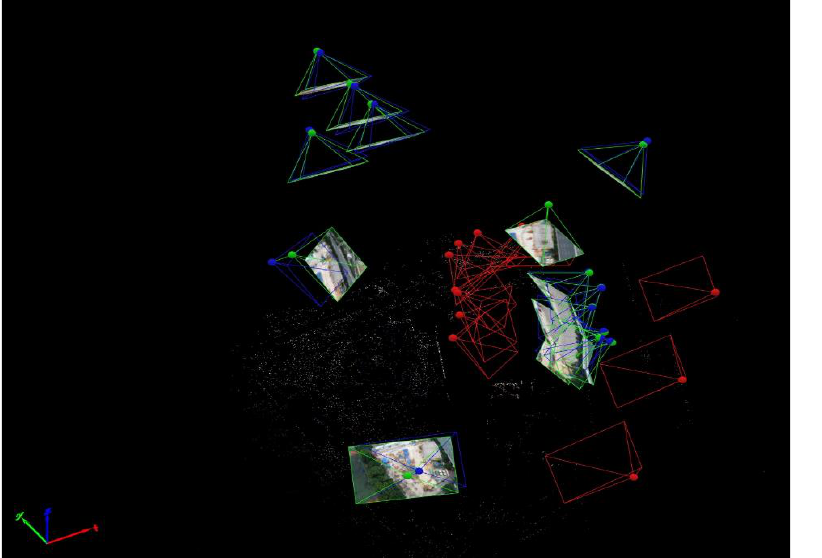
Figure 10. UAV aerial triangulation. Green represents image capture on a Y dimension or coordinate system, orange on the X coordinate, and blue on the Z coordinate; with the three combining to provide the 3D model capture from the point-cloud images.